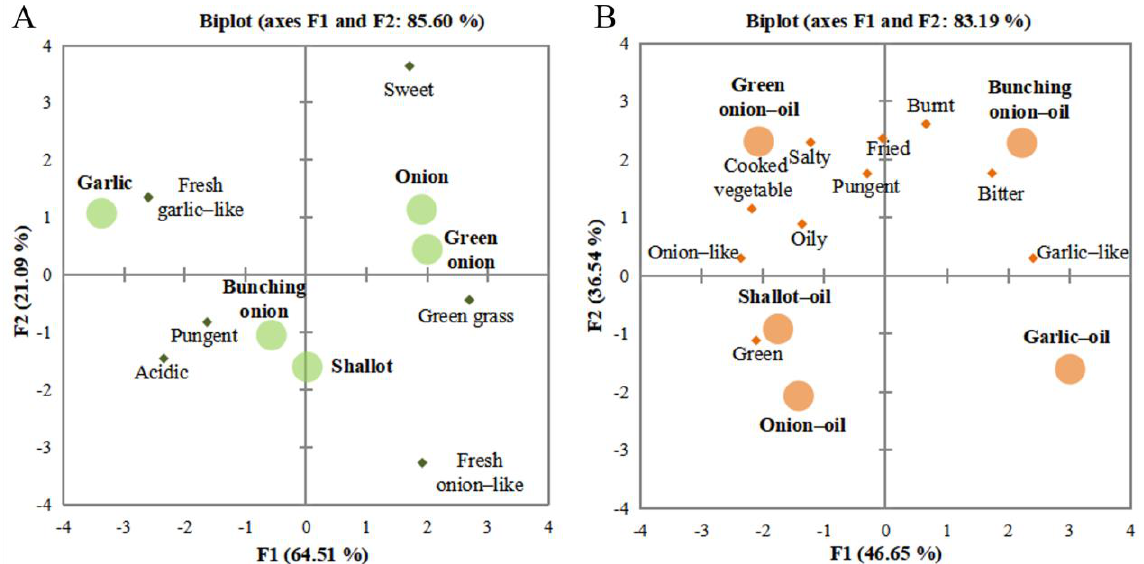
Figure 1. Principal component analysis for sensory analysis of the five samples. (( A ) fresh Allium plants, ( B ) fried Allium oils). Note: the light green circular symbols indicate five fresh Allium plants; the green diamond signs indicate the sensory evaluation descriptions. The light orange circular symbols indicate five fried Allium oils; the orange diamond signs indicate the sensory evaluation descriptions. Fresh Allium plants: green onion, garlic, onion, shallot, and bunching onion. Fried Allium oils: green onion − oil, garlic − oil, onion − oil, shallot − oil and bunching onion − oil.